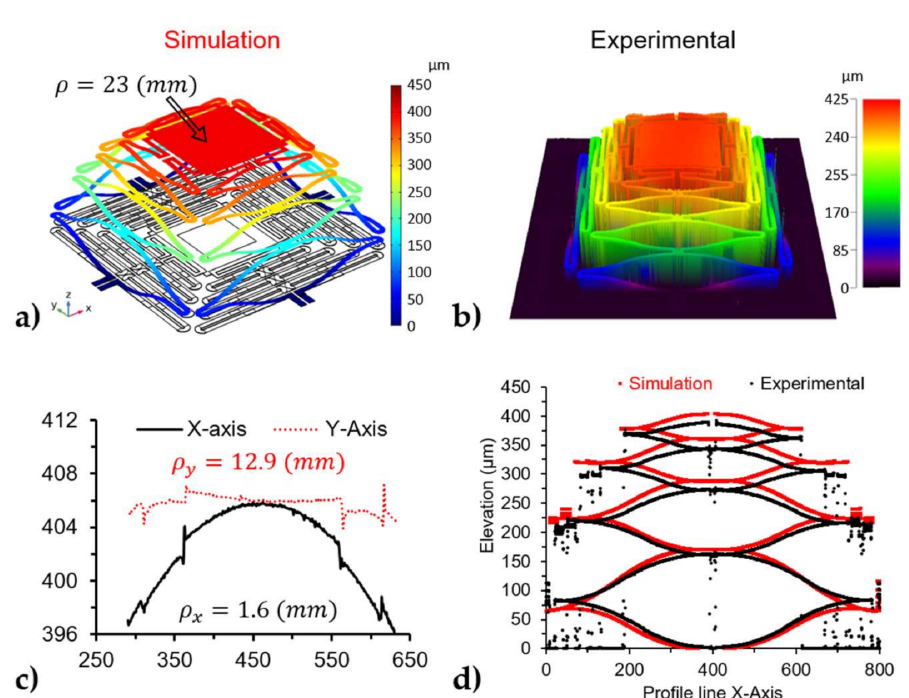
Figure 4. Initial elevation results of the undercarriage: ( a ) Simulation results from the COMSOL model, ( b ) experimental results from the released device (measured 3 months after the release), ( c ) profiles of the undercarriage platform measured at the center of the bonding platform to calculate the radius of curvature for both axis: X and Y, ( d ) comparison between the simulation and experi- mental results, where the profile of a single actuator is plotted together to illustrate the difference between the elevation and deformation of the